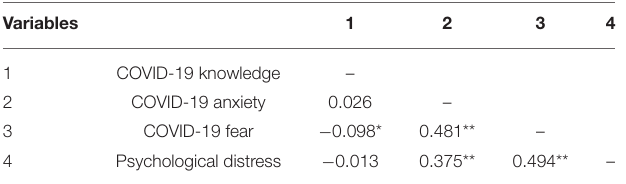
TABLE 5 | Correlations among knowledge, anxiety, fear and psychological distress.